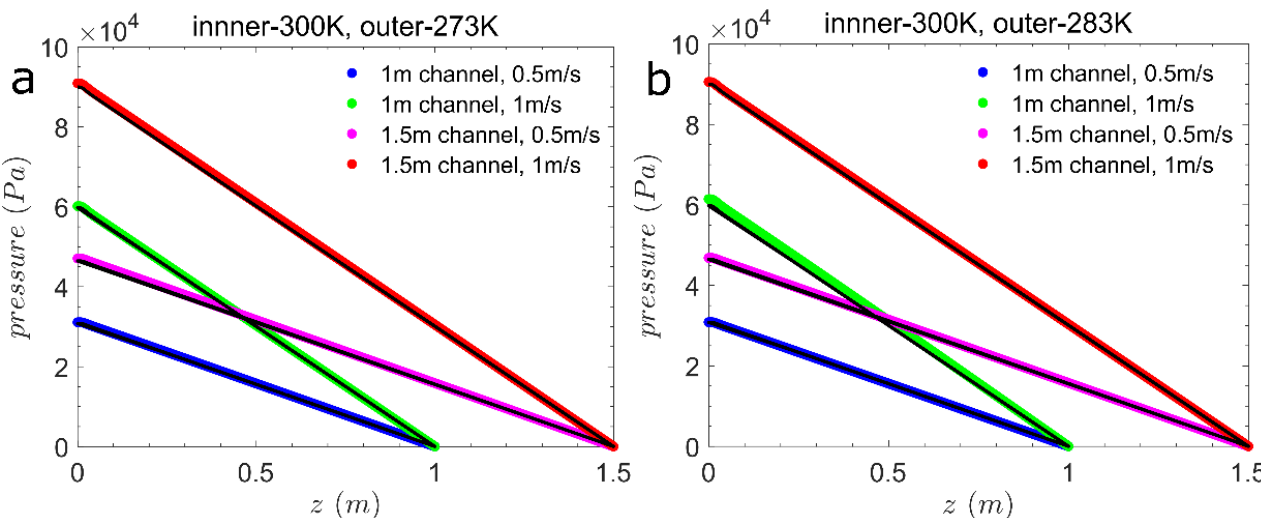
Figure 2. ( a ) Pressure in the straight channels along the axial line, at the inlet velocities of 0.5 m/s and 1 m/s, respectively. In these simulations, the temperature at the channel wall is 273 K, while the temperature of the incoming fluid at the inlet is 300 K. The black lines are the results with no temperature difference, and in these cases, the temperature of the fluid is constant at 300 K. ( b ) Similar to ( a ), but the temperature at the channel wall is 283 K.